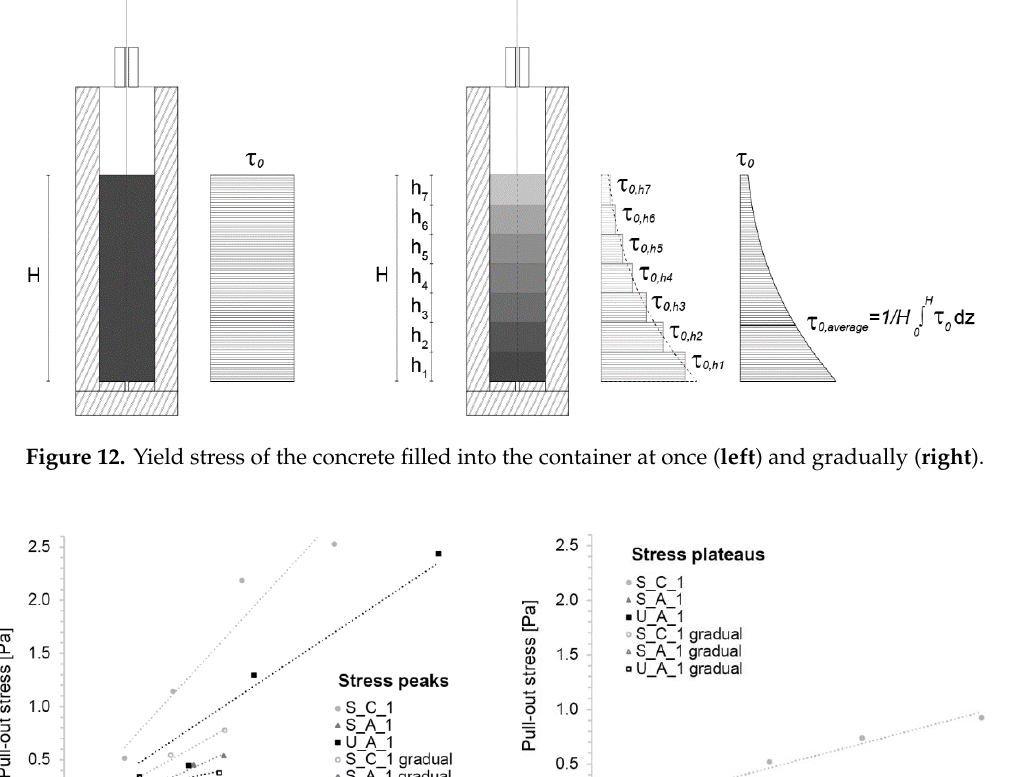
Figure 13. Relation of pull-out stresses to average yield stress measured by the penetrometer. (Left) peak pull-out stress, (right) plateau pull-out stress. Both graphs show the three concrete compositions and the two filling modes.